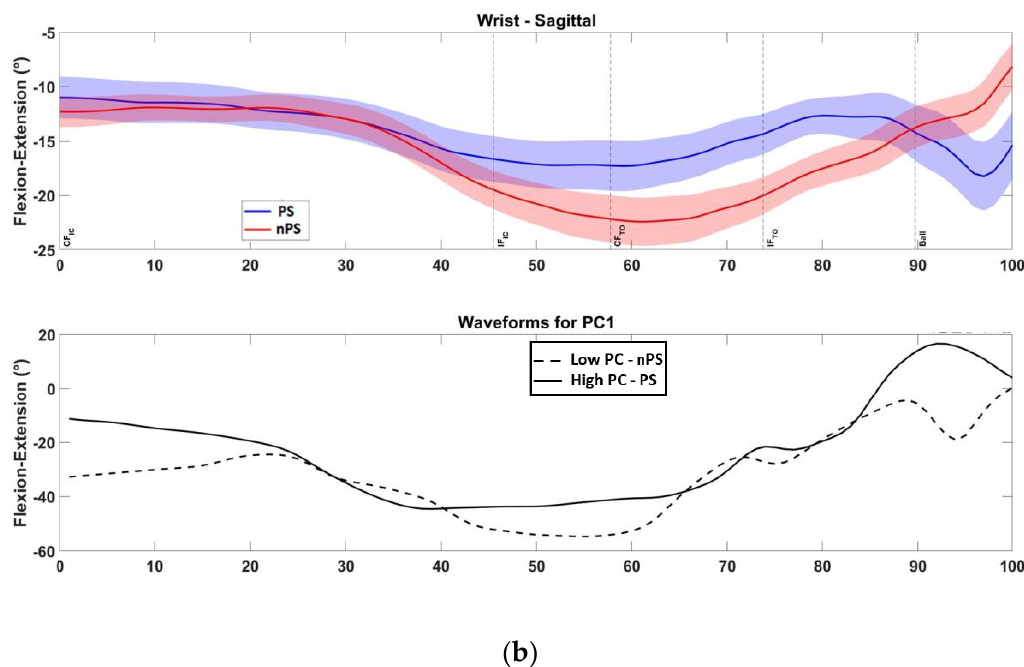
Figure A4. LOW DIVE — Upper Limb, Contralateral : ( a ) in the bottom row, preferred side waveform is represented by the low PC (dashed line) for this kinematic variable; ( b ) in the bottom row, pre- ferred side waveform is represented by the high PC (solid line) for this kinematic variable. Note: PS=preferred diving side; nPS=non-preferred diving side; PC=principal component; IC=initial con- tact; TO=toe-off, CF=contralateral foot; IF=ipsilateral foot; Ball=ball contact.